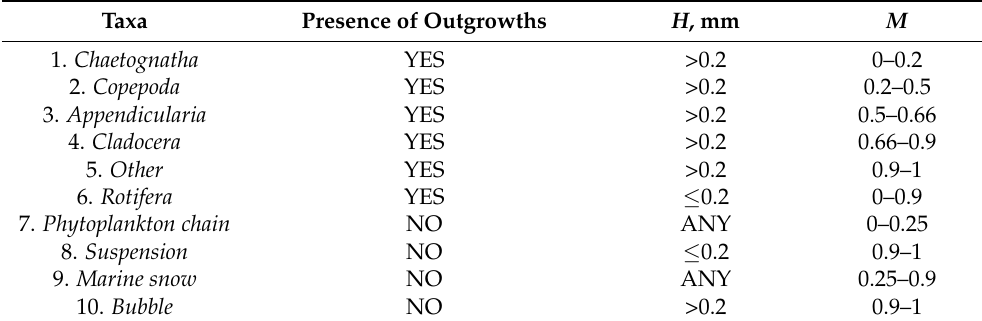
Table 1. Features of taxa for automatic classification of particles: H —length of the rectangle cir- cumscribed around the particle image; M —morphological parameter (width-to-length ratio of the rectangle). Taxa Presence of